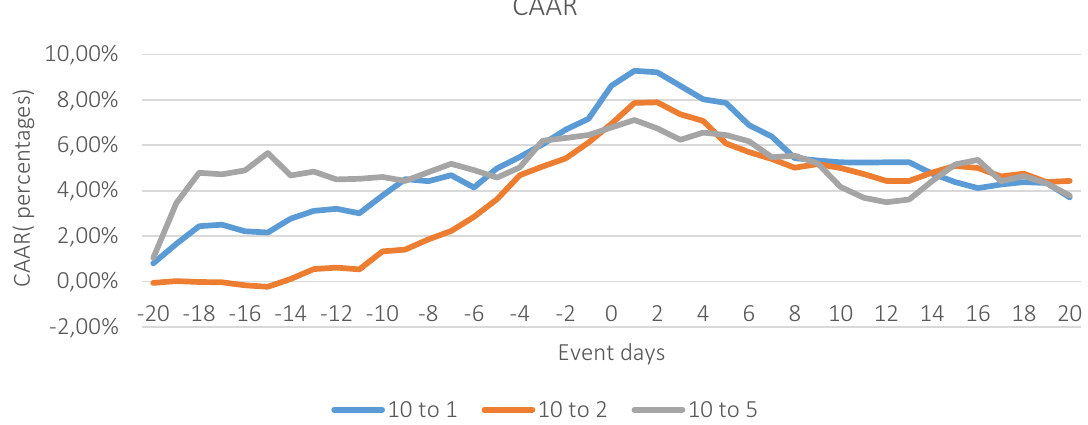
Figure 4. CAARs – Announcement Day (different stock split ratios)